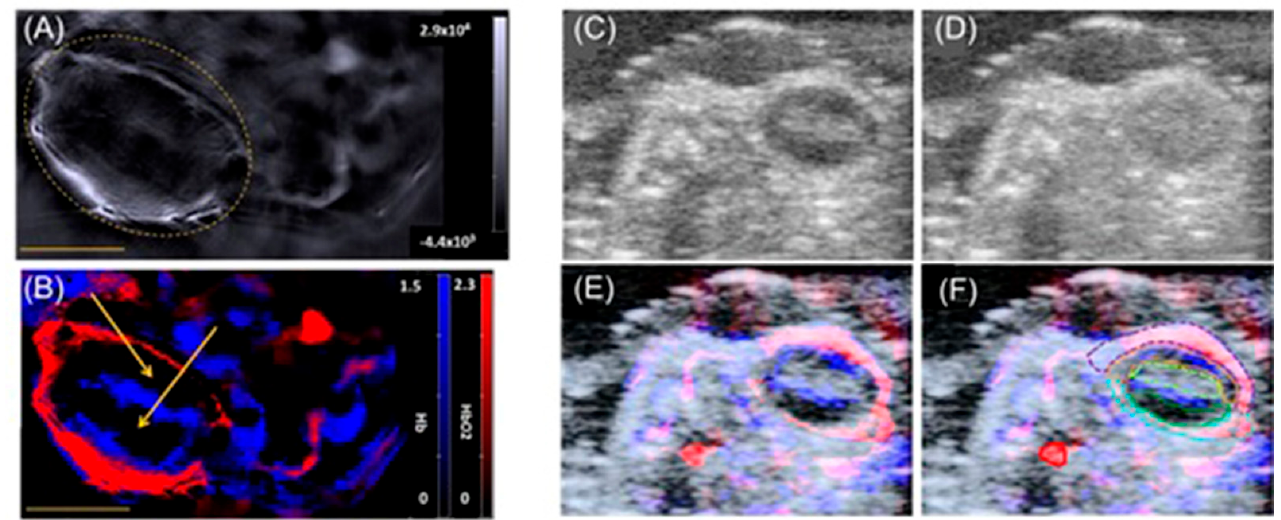
Figure 5. ( A ) A reconstructed single wavelength multispectral optoacoustic tomography image of tumor-bearing mouse at 800 nm. The yellow dashed line indicates the tumor region. ( B ) The corresponding deconvoluted image, showing the distribution of hemoglobin and oxyhemoglobin components in blue and red, respectively. ( C ) An ultrasound image of the tumor-bearing mouse before microbubble injection. ( D ) The ultrasound image of the tumor 40 s after microbubble injection. ( E ) An overlay of the spectrally unmixed optoacoustic image on the ultrasound image after rigid registration of the two images. ( F ) The graphic overlay on ( E ) to indicate the regions of interest analyzed, color-coded as red (blood vessel), purple dashed (upper rim), orange (upper body), light green dashed (core), dark green (lower body), and cyan dashed (lower rim). The yellow scale bars in ( A ) and ( B ) represent 5 mm. Adapted from Photoacoustics , 8 , Shah, A.; Bush, N.; Box, G.; Eccles, S.; Bamber, J. Value of combining dynamic contrast-enhanced ultrasound and optoacoustic tomography for hypoxia imaging, 15–27, Copyright (2017), with permission from Elsevier [249].